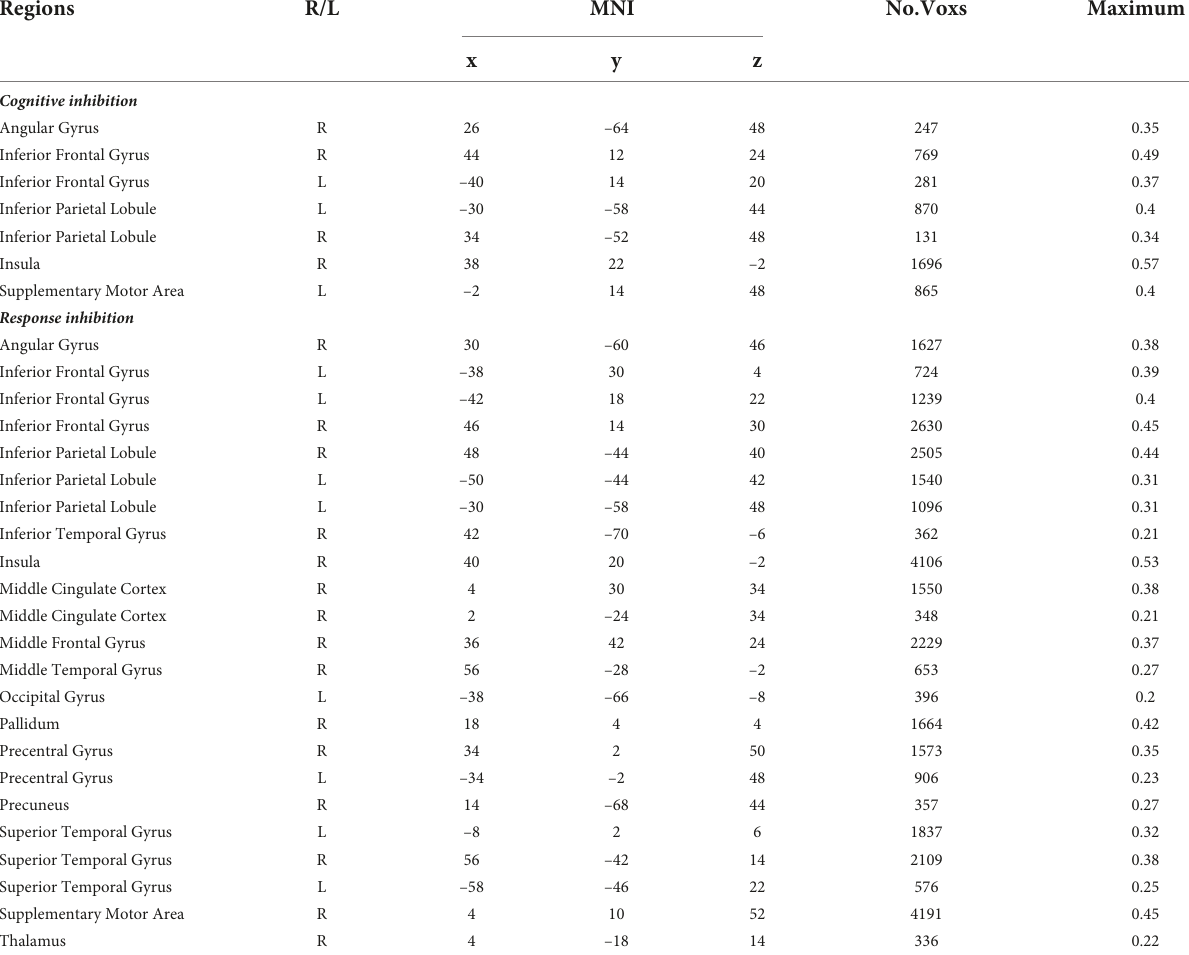
TABLE 1 Brain activation in two subcomponents of inhibitory